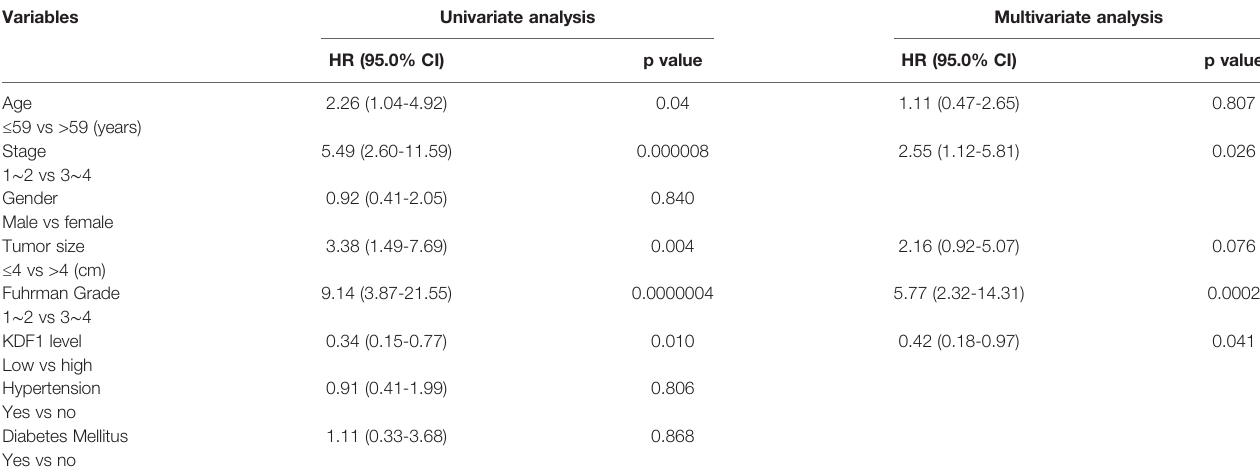
TABLE 3 | Univariable and multivariable Cox regression analysis for Disease speci fi c survival.